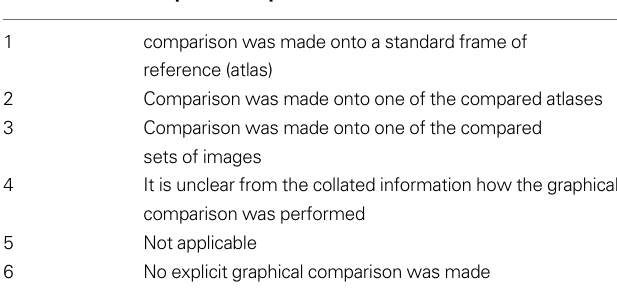
Table 2 | The set of possible values of the variable reference frame, associated with the mode of graphical comparison of two nervous system parts defi ned in different